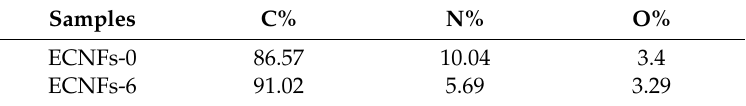
Table 2. The element compositions of ECNFs-0 and ECNFs-6 from XPS analysis.